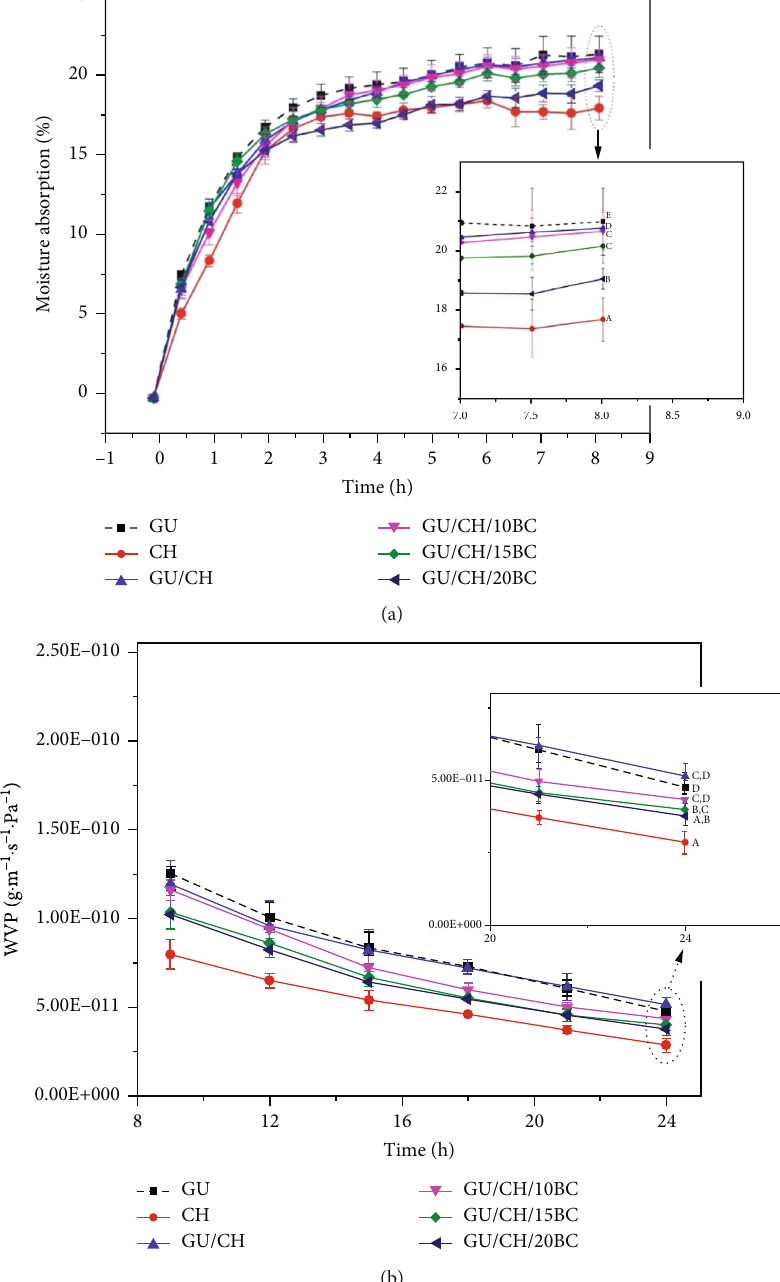
Figure 6: Average value of moisture absorption (a) and WVP (b) of each studied fi lm. Di ff erent letters a, b, c, d, and e in the inset indicate signi fi cant di ff erences ( p ≤ 0 : 05